Question: In one sentence, what is this figure communicating?
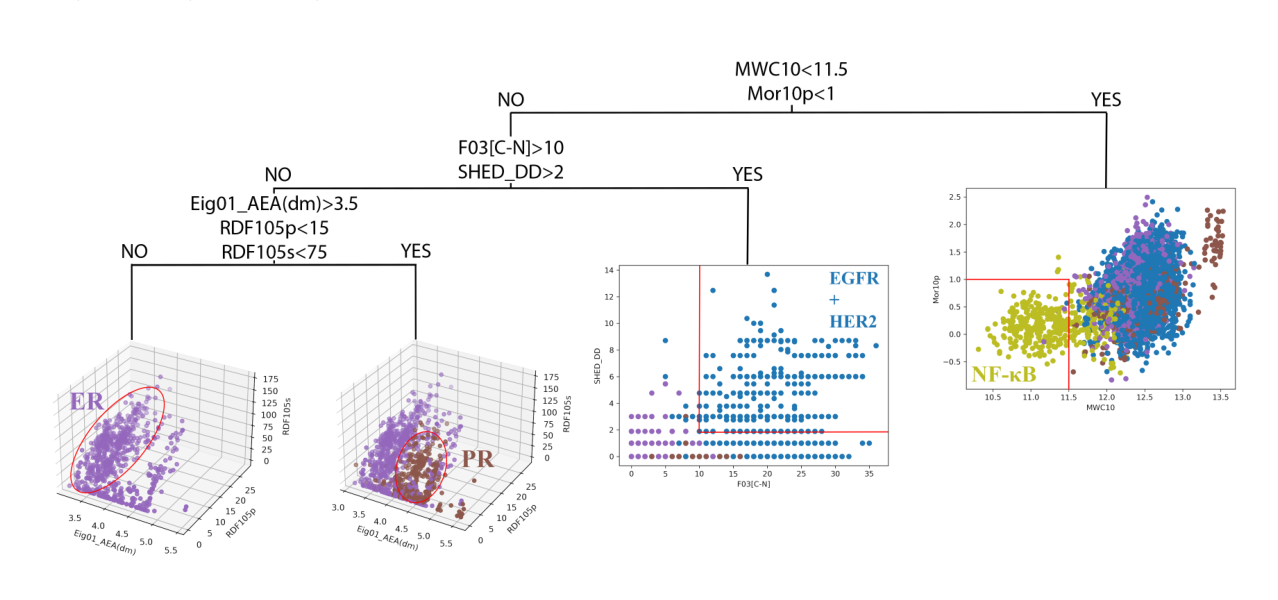
Answer: A simple questionnaire dendrogram to separate ligands with a number of features and determine the targets of them.